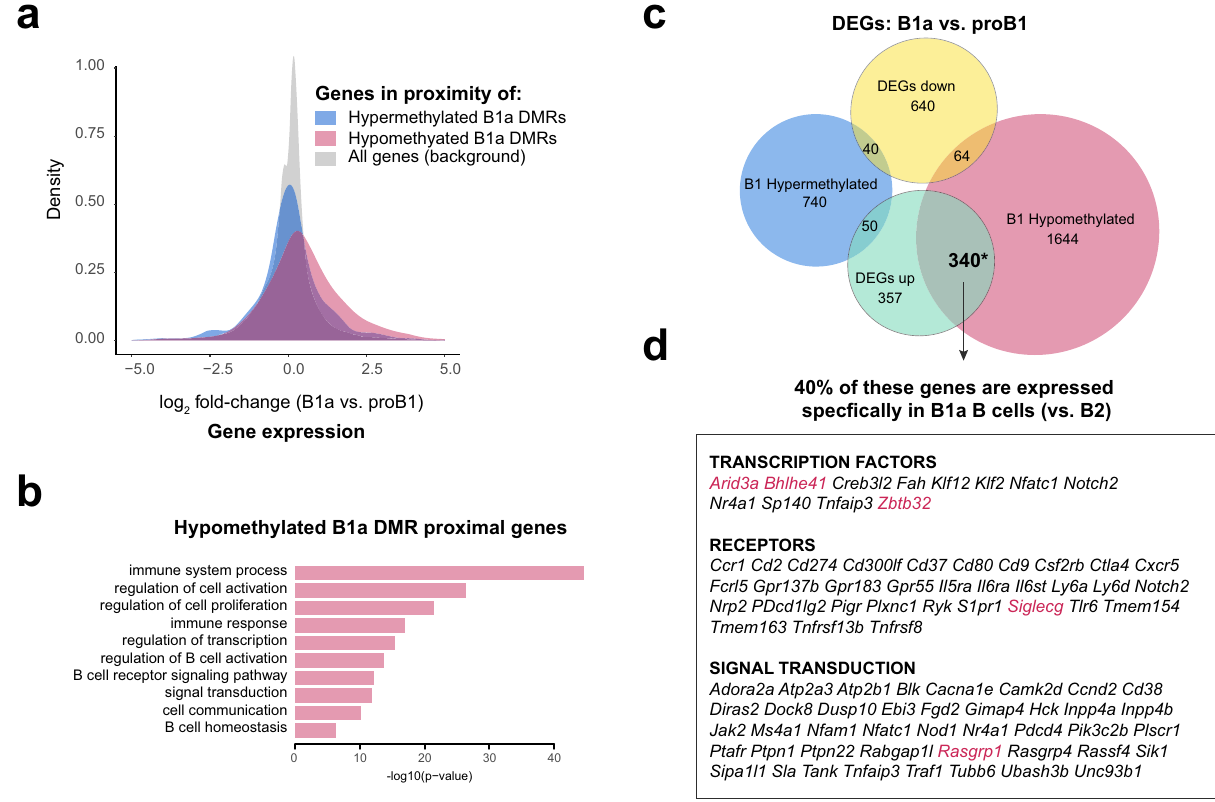
Fig. 3 B1 lineage-speci fi c gene expression is linked to enhancer demethylation. a Distribution of fold-changes in gene expression between mature B1a (peritoneal B1a or fetal liver FrE) and proB1 (fetal liver FrBC) cells. Genes in the proximity of developmentally hypomethylated or hypermethylated B1a DMRs are depicted alongside the set of all genes. Microarray data from the ImmGen Consortium was used for this analysis. b Enriched Gene Ontology (Biological Process) terms for genes in the proximity of hypomethylated B1a DMRs. c Overlap between differentially expressed genes and genes in the proximity of DMRs between B1a (peritoneal B1a or fetal liver FrE) and proB1 (fetal liver FrBC) cells. Gene sets with a signi fi cant overlap are marked with an asterisk ( p < 0.001, Fisher ’ s exact test). d B1a lineage-speci fi c genes in the signi fi cantly overlapping set shown in c . Source data are provided as a Source Data fi